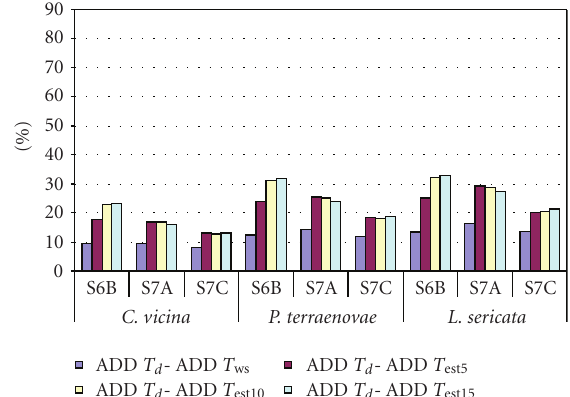
Figure 4: Di ff erences between ADD T d and ADD values using T ws and correlations compared to ADD T d , expressed as percentages ([ADDx-ADD T d )/ADD T d ] × 100) for data registered in